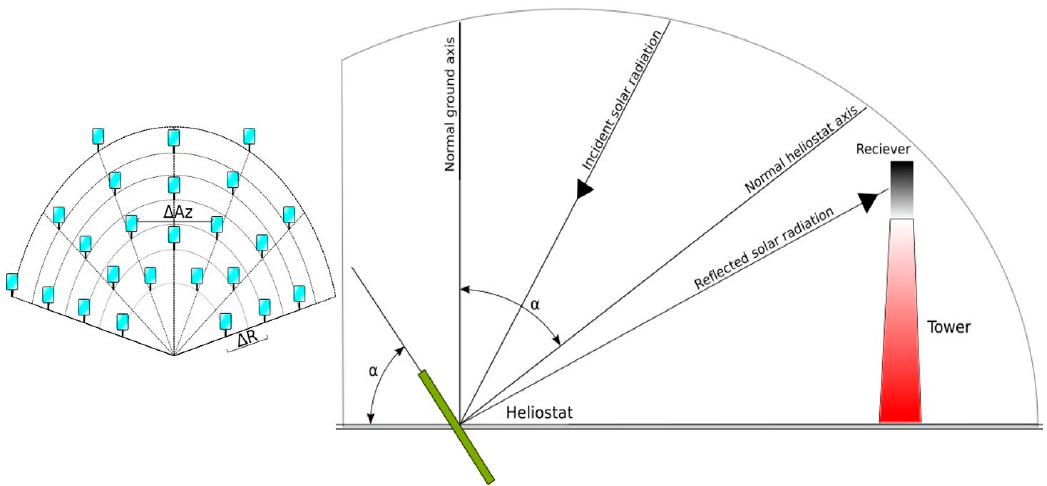
Figure 1. Implementation of the heliostats field. Representation of the optical angle α .